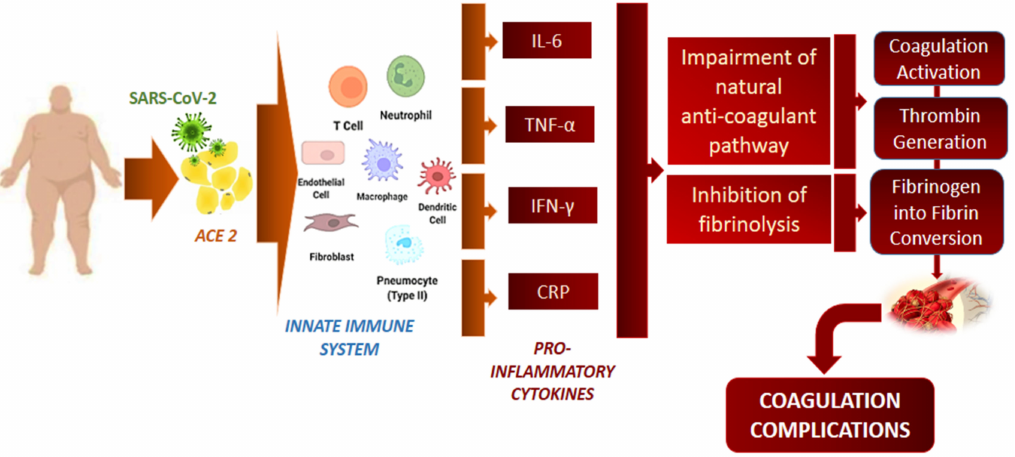
Figure 2. The relation between SARS-CoV-2 infection and coagulation complications. Infection with SARS-CoV-2 stimulates the innate immune system by releasing proinflammatory cytokines. Interleukin (Il)-6, tumour necrosis factor (TNF)- α , interferon (IFN)- γ and C-reactive protein (CRP) interfere with the anticoagulant pathway and inhibit fibrinolysis. Due to all these mechanisms, coagulation is stimulated and ends with fibrin